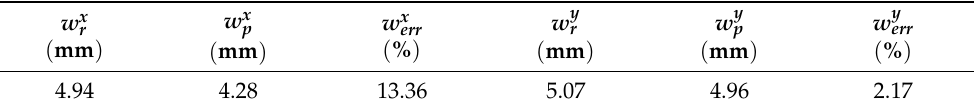
Table 2. The weld width comparison between the reconstructed weld pool surface and the measured